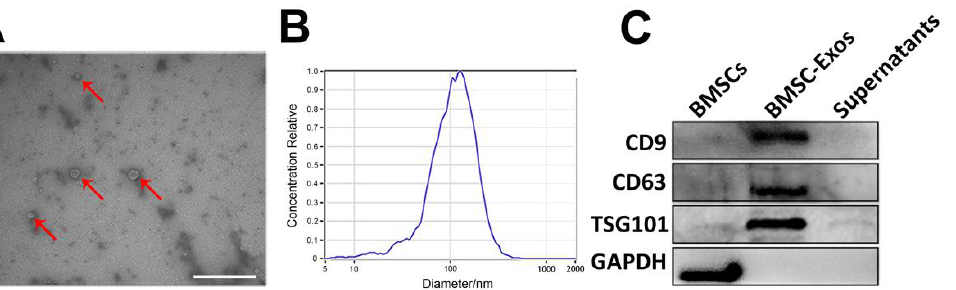
Figure 1. Characterization of BMSCs. ( A ) P3 BMSCs adopted a uniformly spindle-shaped popula- tion. Scale bars = 2 00 μm. ( B ) Osteogenic differentiation of BMSCs demonstrated by Alizarin Red S staining. Scale bars = 5 0 μm. ( C ) Adipogenesis differentiation of BMSCs demonstrated by Oil Red O staining. Scale bars = 5 0 μm. ( D ) Flow cytometric analysis of cell surface markers indicated that BMSCs expressed CD29 and CD90 other than CD34 and CD45. BMSCs, bone marrow mesenchymal stem cells; P3, passage 3.